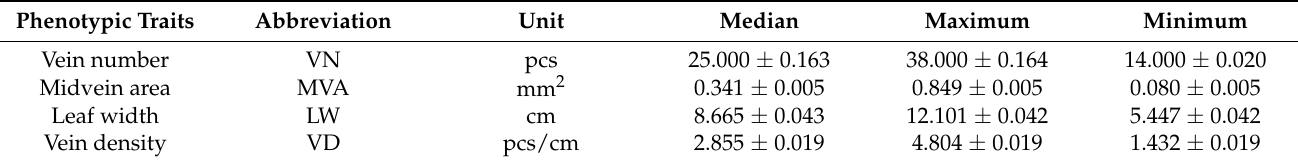
Table 2. Phenotypic variations in leaf vein traits at ear leaf of maize among 300 inbred